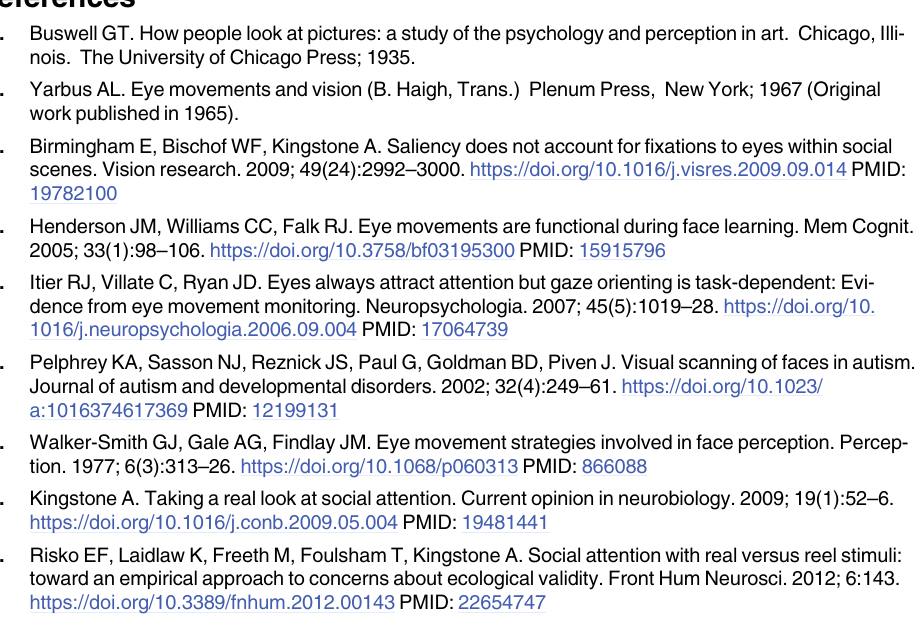
S1 Fig. Follow-up analysis of gaze behavior to eyes for subgroups (instruction-type aligned with participants’